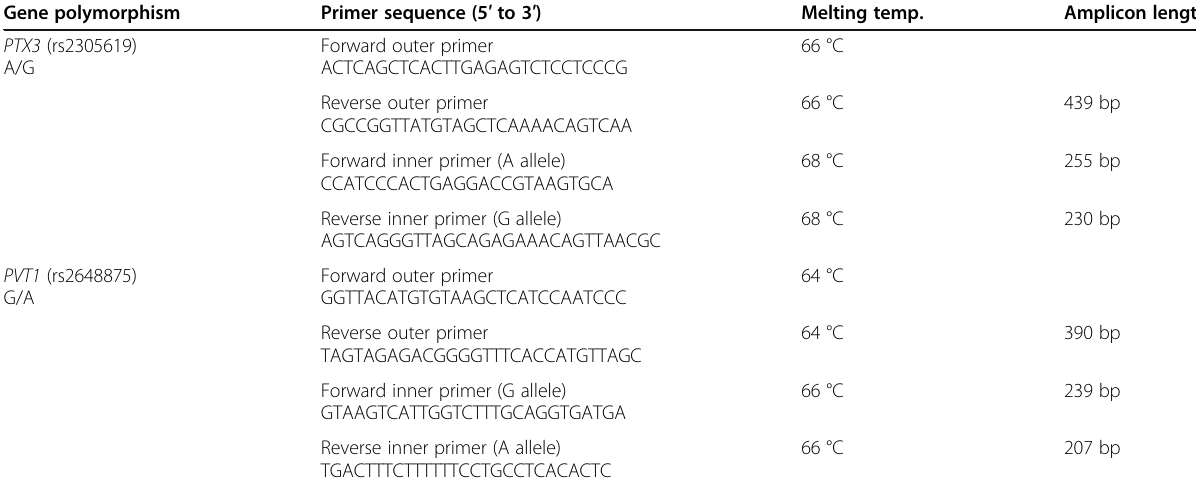
Table 1 Designed primer sequences used in Tetra-Arms PCR genotyping Gene polymorphism Primer sequence (5 ′ to 3 ′ ) Melting